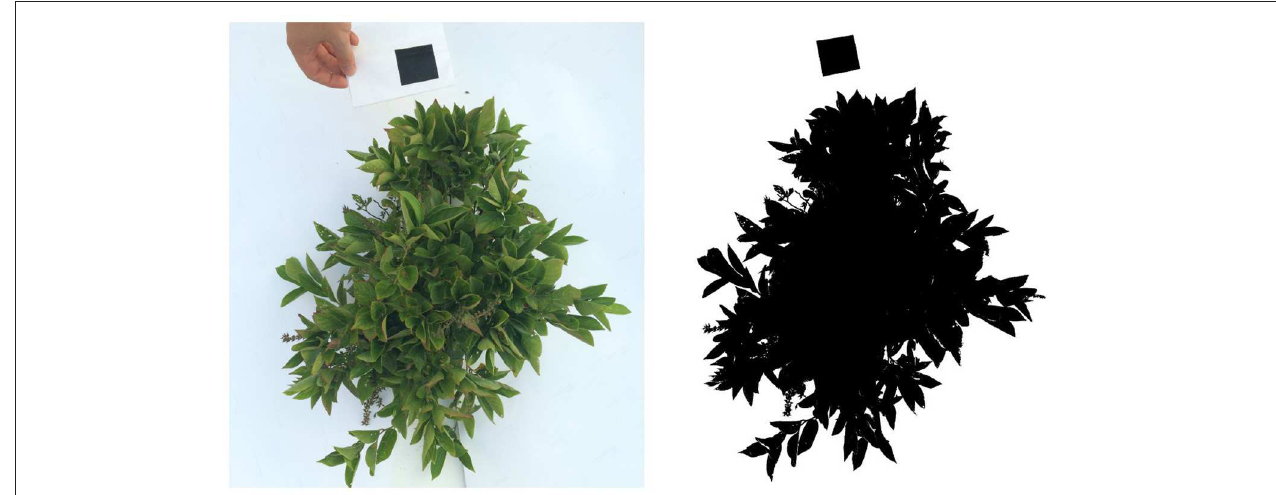
FIGURE 3 | Image area analysis, original image (left) and processed image (right). TABLE 1 | Model